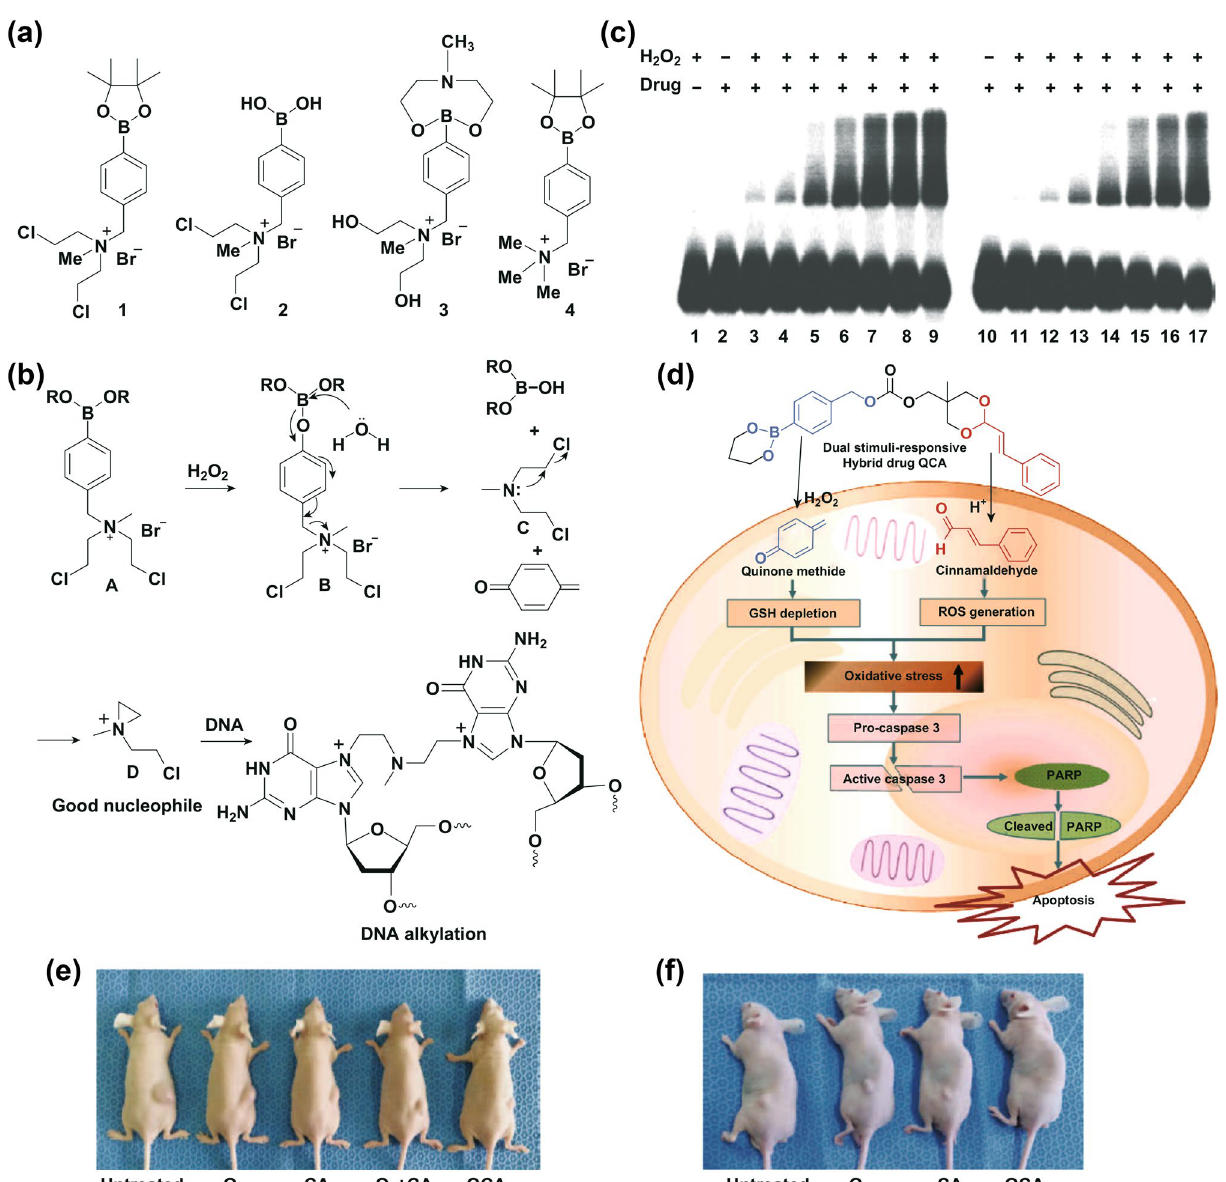
Fig. 9 a Compounds 1–4. b Formation of interchain crosslinks (ICL) induced by 1 and 2 during H 2 O 2 activation. b Release of nitrogen mustard from compound 1 upon treatment with H 2 O 2 . c The concentration dependence of compounds 1 and 2 on DNA cross-linking formation upon H 2 O 2 activation. Lane 1 without drug; lanes 2–9 with drug 1: lane 2, without H 2 O 2 (cross-linking yield 0%); lane 3, 50 μM H 2 O 2 + 100 μM 1 (2.2%); lane 4, 100 μM